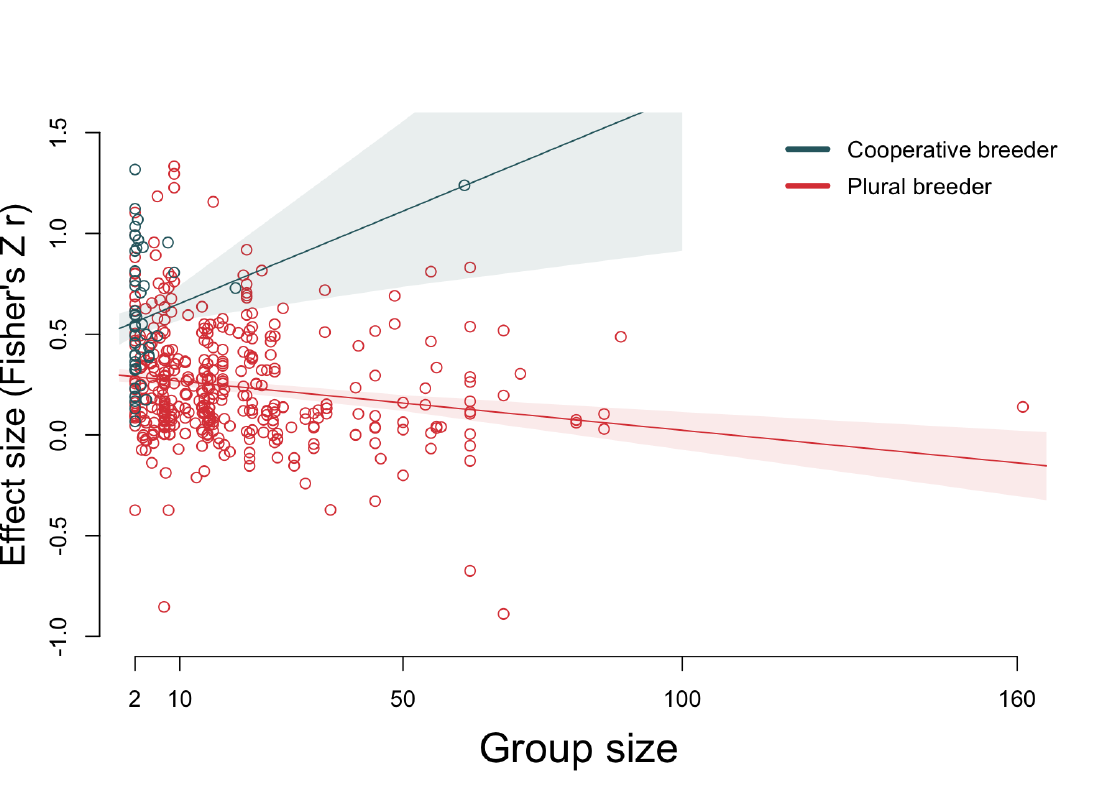
Figure 10. The relationship between the number of females in the group and the effect of dominance on reproductive success depends on whether the species is a cooperative (olive dots show data and olive line with shading shows estimate from rethinking model) or a plural breeder (red dots show data and red line with shading shows estimate from rethinking model). In cooperative breeders, effect sizes increase with increasing group size as a single female continues to monopolize reproduction in the group, whereas effect sizes decrease with increasing group size as dominants can potentially no longer outcompete all other